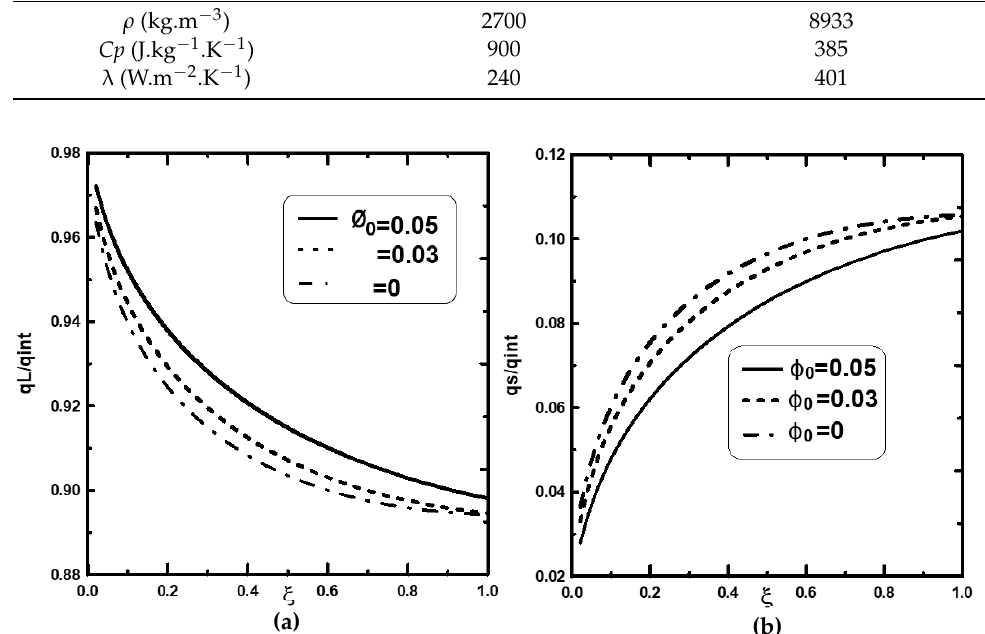
Figure 5. Effect of inlet nanoparticles volume fraction on the latent ( a ) and sensible ( b ) heat fluxes: T 0 = 293.15 K, T 0L = 293.15 K, T w = 293.15 K, q 1 = − 1000 W/m 2 , c 0 = 0.3, u 0 = 1 m/s, m 0L = 0.015 kg/m.s, H = 1 m, d = 0.015 m, p 0 = 1 atm.